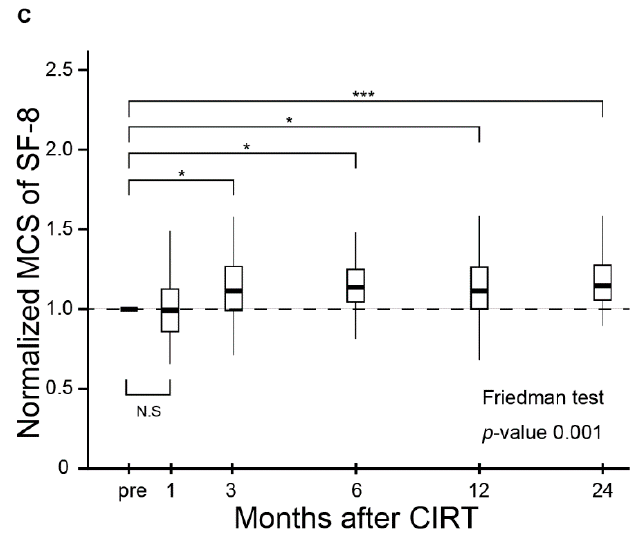
Figure 2. The MSTS scores, PCS of SF-8, and MCS of SF-8 are shown in box-plots including median values and interquartile ranges before CIRT and at 1, 3, 6, 12, and 24 months after CIRT. ( A ) The MSTS score did not change during the follow-up period. ( B ) The PCS of SF-8 did not change during the follow-up period. ( C ) The MSC of SF-8 improved significantly after CIRT during the follow-up period. Abbreviations: N.S = not significant; * = p -value < 0.05; *** = p -value < 0.001. The relationships among the total scores of the scales (MSTS and PCS and MCS of SF-8) were evaluated by analyzing the correlation between functional outcomes and QOL scores (Figure 3A–C). KPS, PCS and MCS of SF-8 were determined independently in our study. The MSTS score was positively correlated with the PCS of SF-8 (Figure 3A; corre- lation coefficient: 0.55; p < 0.001). A weak positive correlation was detected between the MSTS score and the MCS of SF-8 (Figure 3B; correlation coefficient: 0.25; p < 0.01). A sim- ilar but weaker positive correlation was observed between the PCS and MCS of SF-8 (Fig- ure 3C; correlation coefficient: 0.11; p = 0.03).